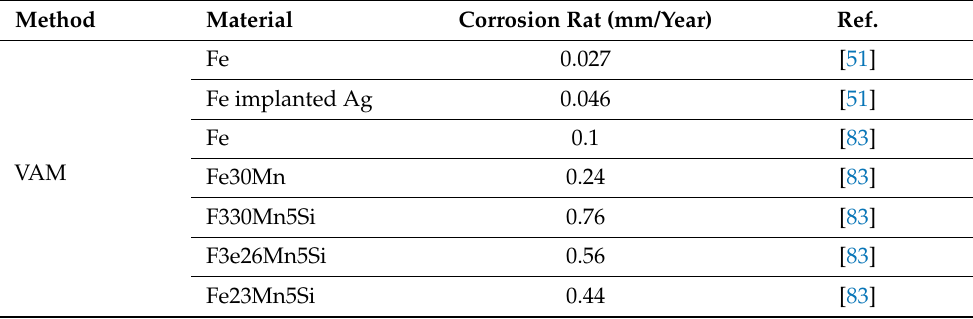
Table 5. Corrosion rates for Fe-based materials obtained by vacuum arc melting.